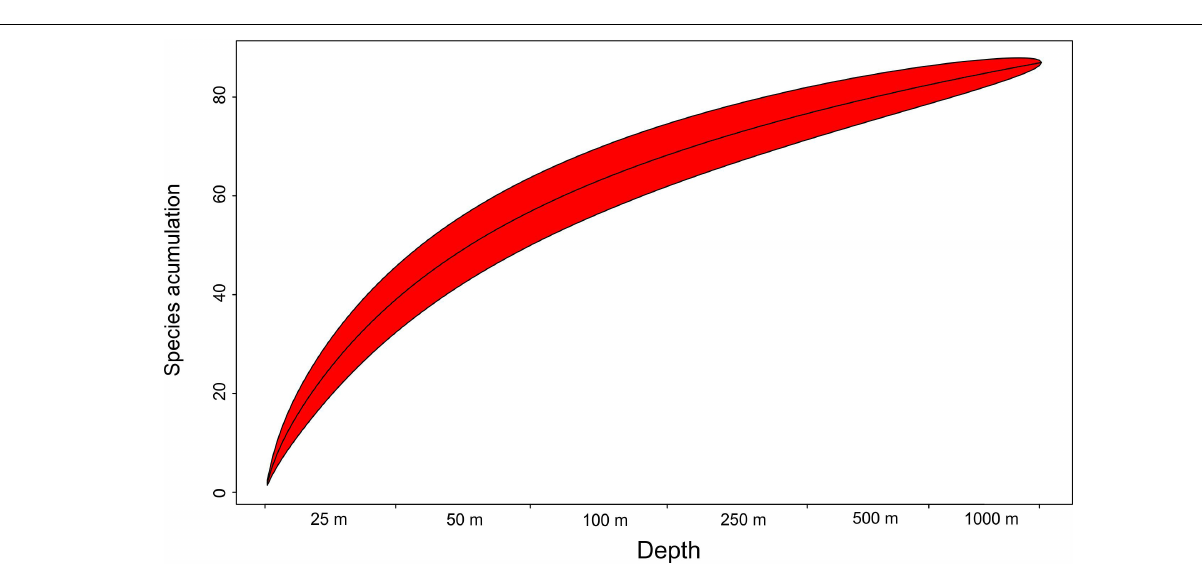
FIGURE 6 | Species accumulation curve with Chao 1.